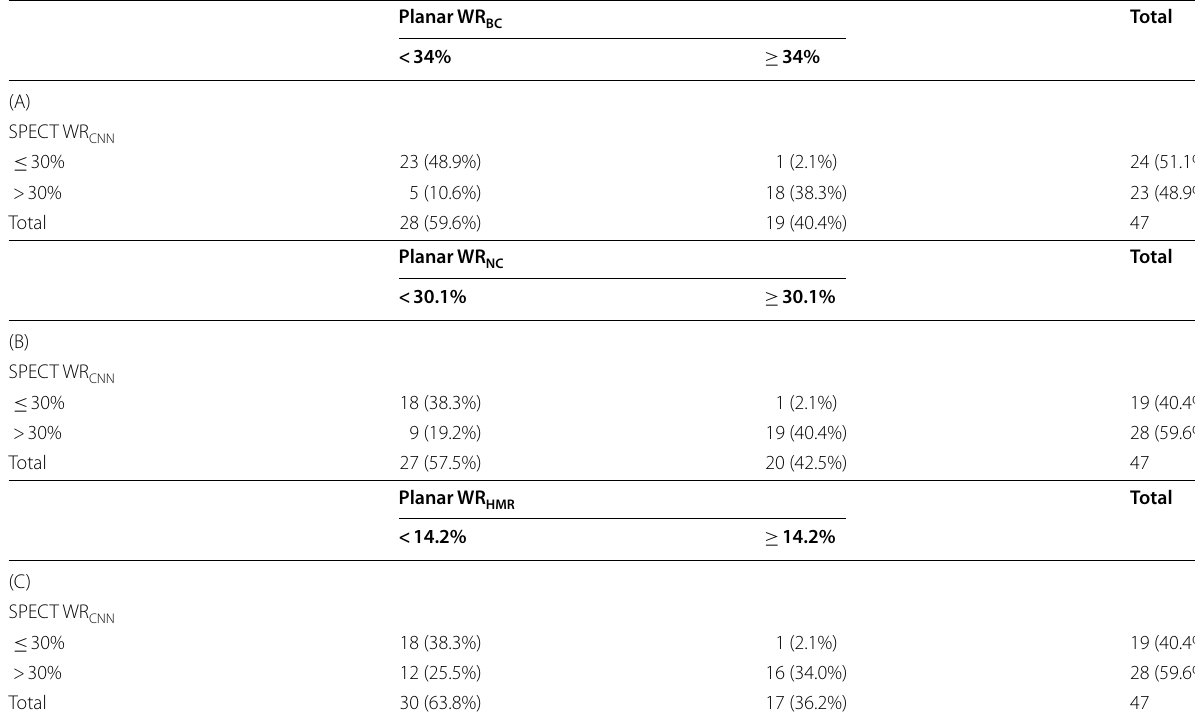
Table 2 Washout rates determined from SPECT and planar images using CNN-based and standard methods,